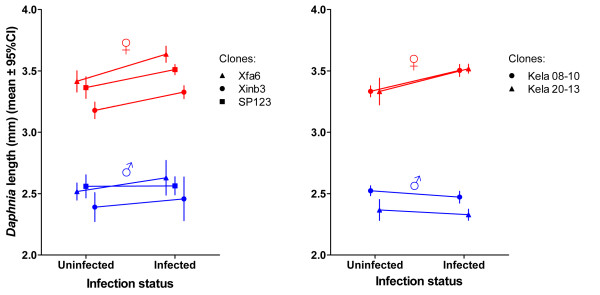
Body length of infected versus uninfected male and female hosts, 21 days post-exposure. P. ramosa induced gigantism in female D. magna but not in males (see Table 2 for details). Error bars show 95% confidence intervals. Stars in the legend represent significant differences based on t-test comparisons (P < 0.0001). The results for females remain significant (P < 0.01) when corrected for multiple testing. Note that P > 0.2 in all comparisons for males.